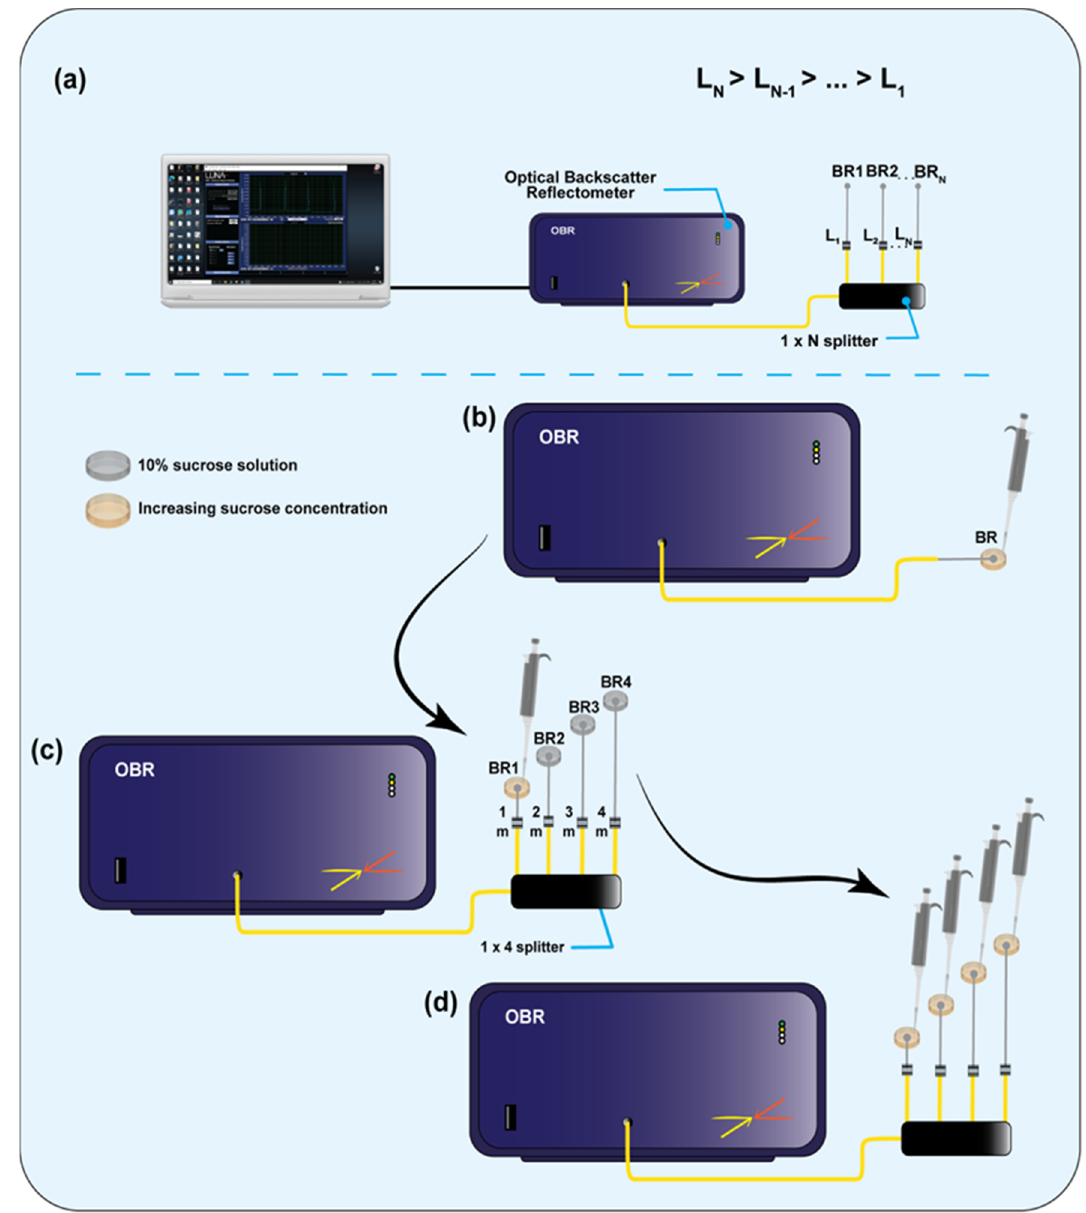
Figure 3. Schematics of the experimental setup. ( a ) General schematic of the proposed SDM-based multiplexing system for an arbitrary number of ball resonators (BRs), where L i —the length of the fiber for each i-th channel and N—total number of channels. ( b ) Schematic of individual resonator calibration setup (no network; no cross-sensitivity). ( c ) Schematic of individual resonator calibration—one at a time—within multiplex network (network; minimum cross-sensitivity). ( d ) Schematic of simultaneous calibration within multiplex network (network; cross-sensitivity).